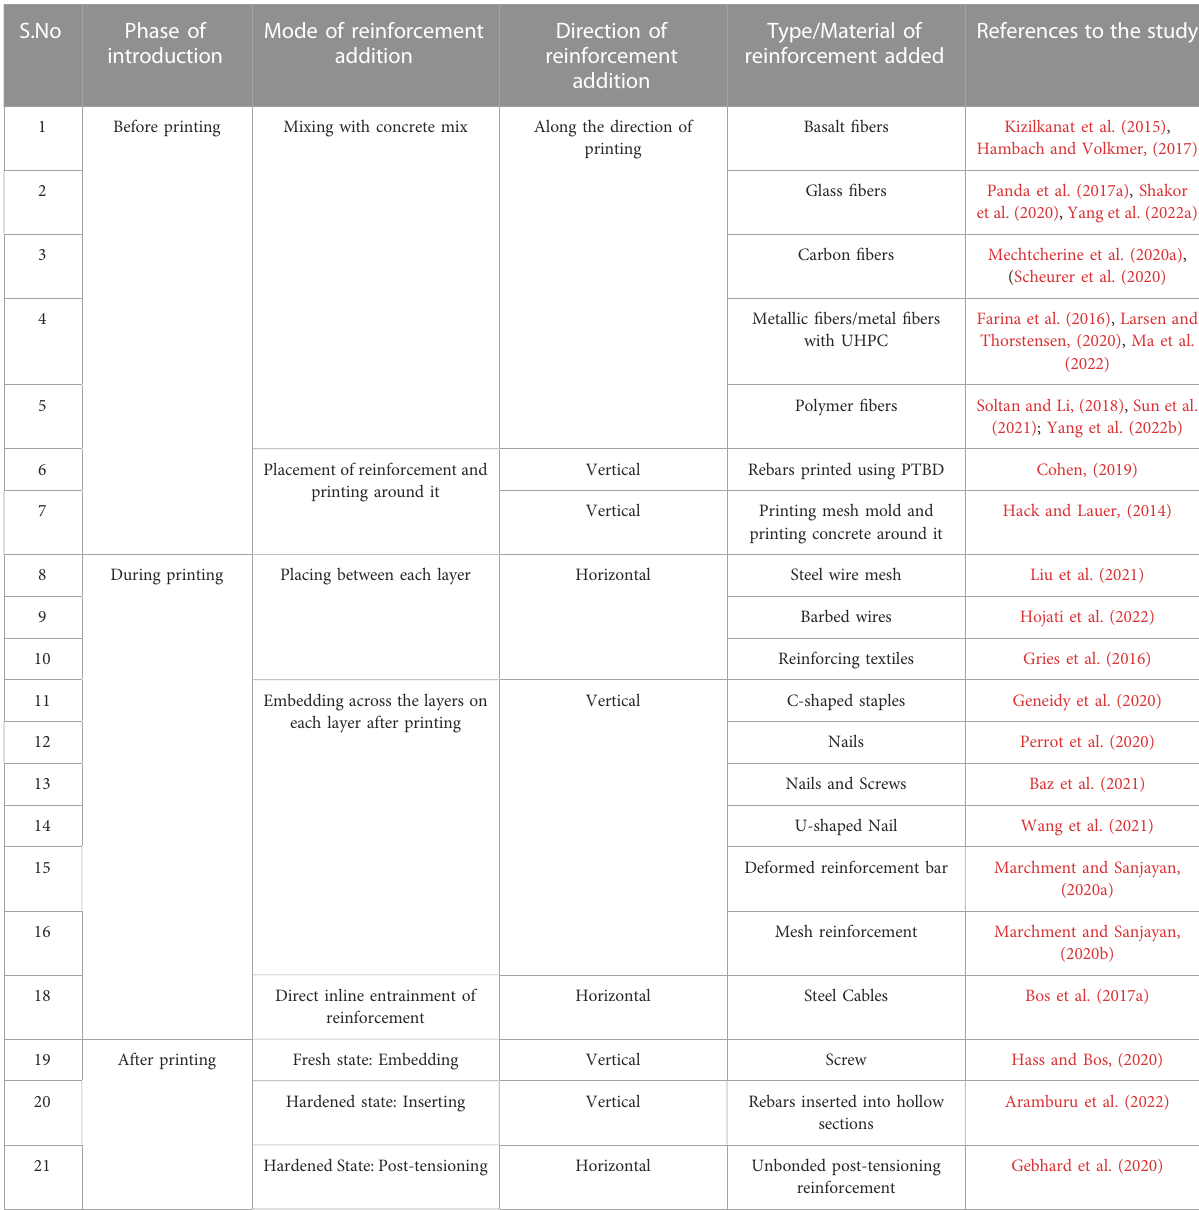
TABLE 1 Studies made on different reinforcement techniques in concrete